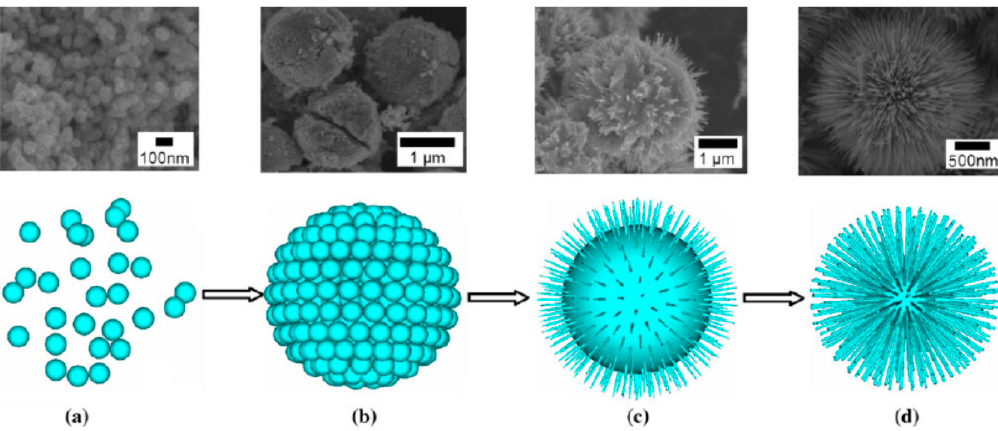
Figure 9. Schematic illustration of the formation process of 3D urchin-like hierarchical TiO 2 : ( a ) nanoparticle; ( b ) microsphere; ( c ) similar urchin-like sphere; ( d ) urchin-like sphere [30].